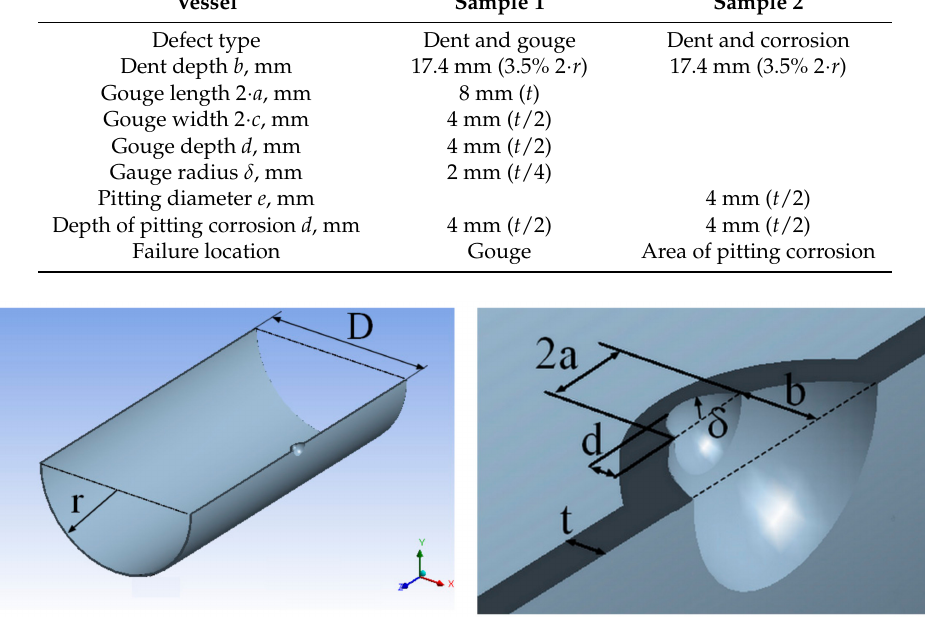
Figure 1. The geometry of the combined defect: a denotes a half-length of the gouge, mm; b is the depth of the dent, mm; c is the width of the gouge, mm; d is the depth of the gauge, mm; t is wall thickness, mm; r is the internal radius of the pipe, mm, and D is the external diameter of the pipe,